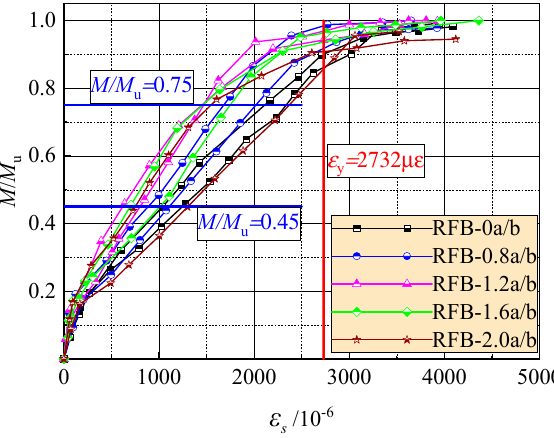
Figure 5. Strain of the longitudinal tensile rebar at different loading levels.